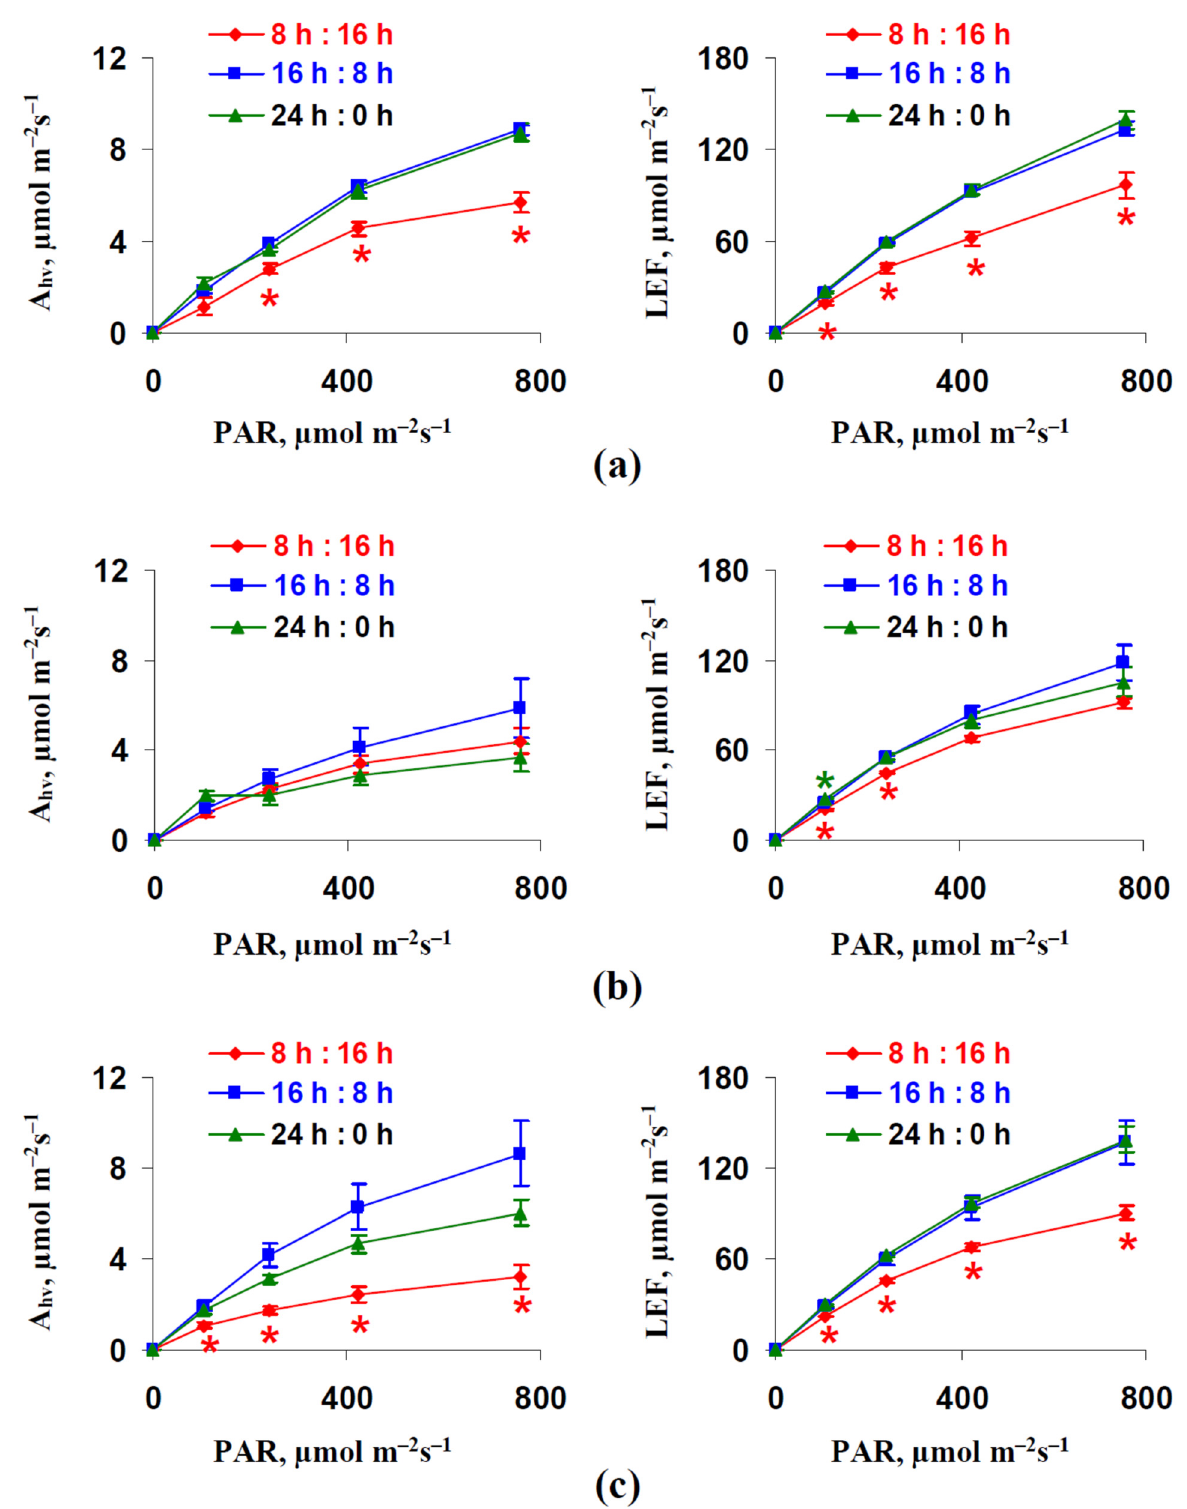
Figure 2. Dependences of the photosynthetic CO 2 assimilation rate (A hv ) and linear electron flow (LEF) on intensity of the actinic light (photosynthetically active radiation, PAR) after 18 days ( a ), 25 days ( b ), and 32 days ( c ) of cultivation ( n = 6). “8 h:16 h” is 8 h (light):16 h (dark), “16 h:8 h” is 16 h (light):8 h (dark), and “24 h:0 h” is 24 h (light):0 h (dark). *, difference from control plants cultivated under 16 h (light):8 h (dark) were significant ( p < 0.05).